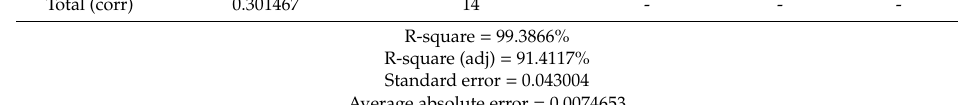
Table 4. Coefficients of the Special Cubic Model for Si-Fe-Ni mixture design. Table 4. Coe ffi cients of the Special Cubic Model for Si-Fe-Ni mixture design.